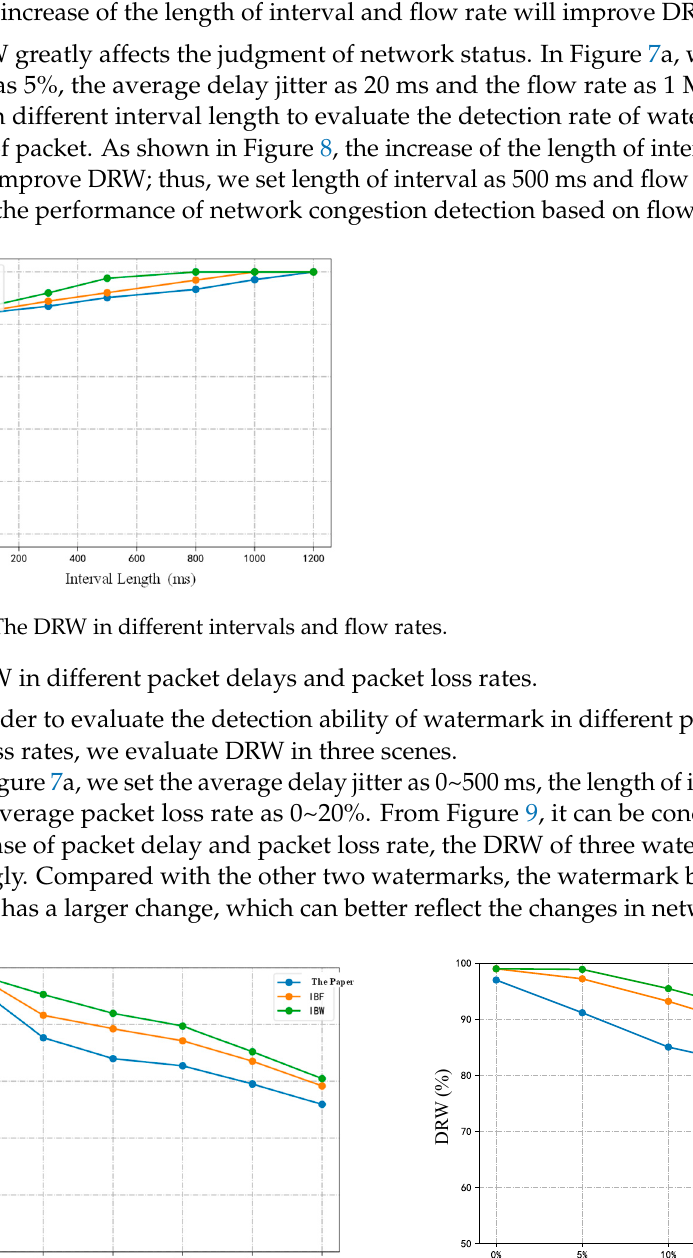
Figure 7. The experimental network topology.